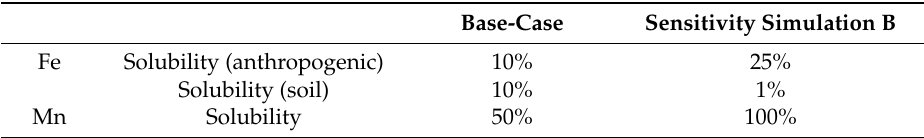
Table 5. Increase in the Fe and Mn solubilities in sensitivity simulation